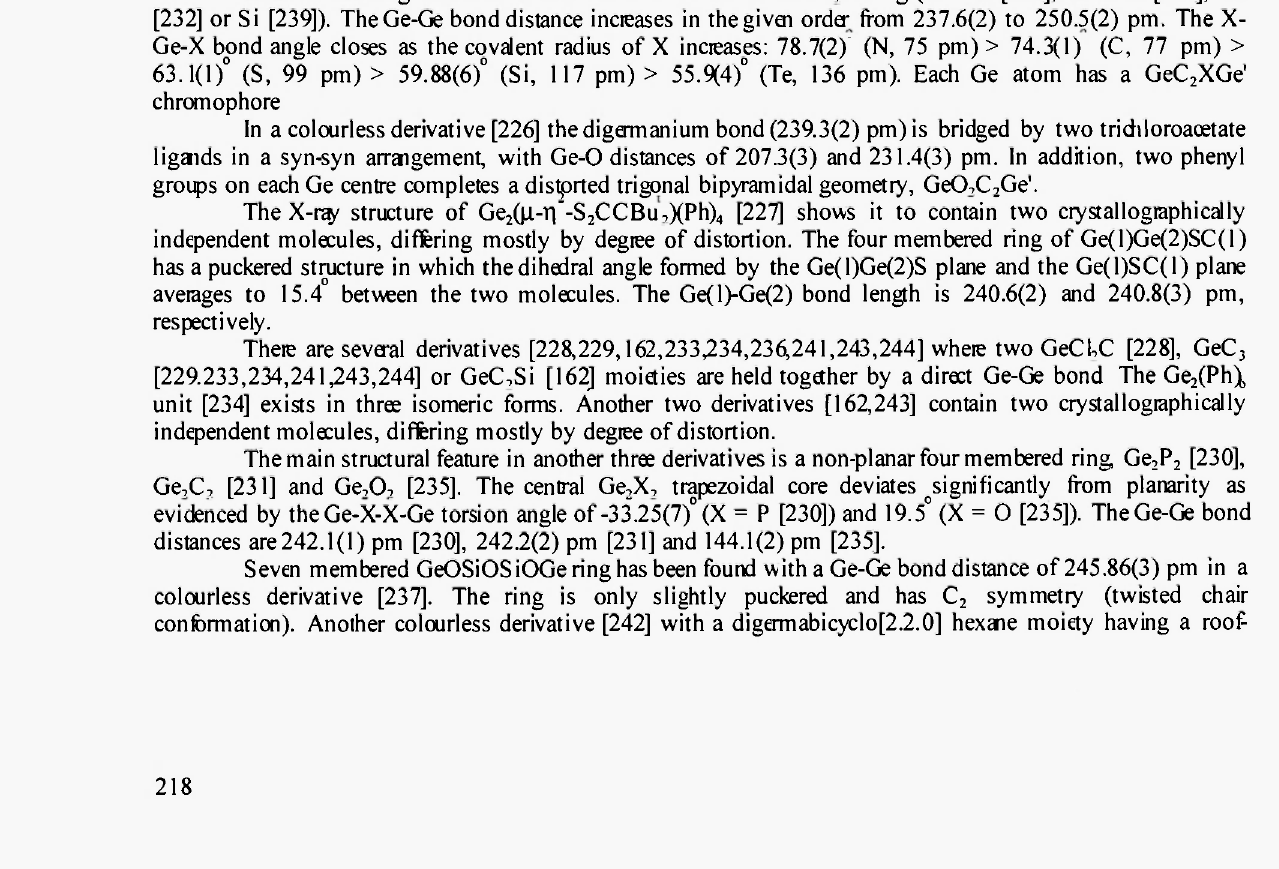
Fig.6. Structure of GejQl-T^-tmteh) I 4 [222] (A) projection on theC(l)C(2)S plane (B) projection on theplaneof symmetry of the molecule (omitting the I and C(7)-C(10)